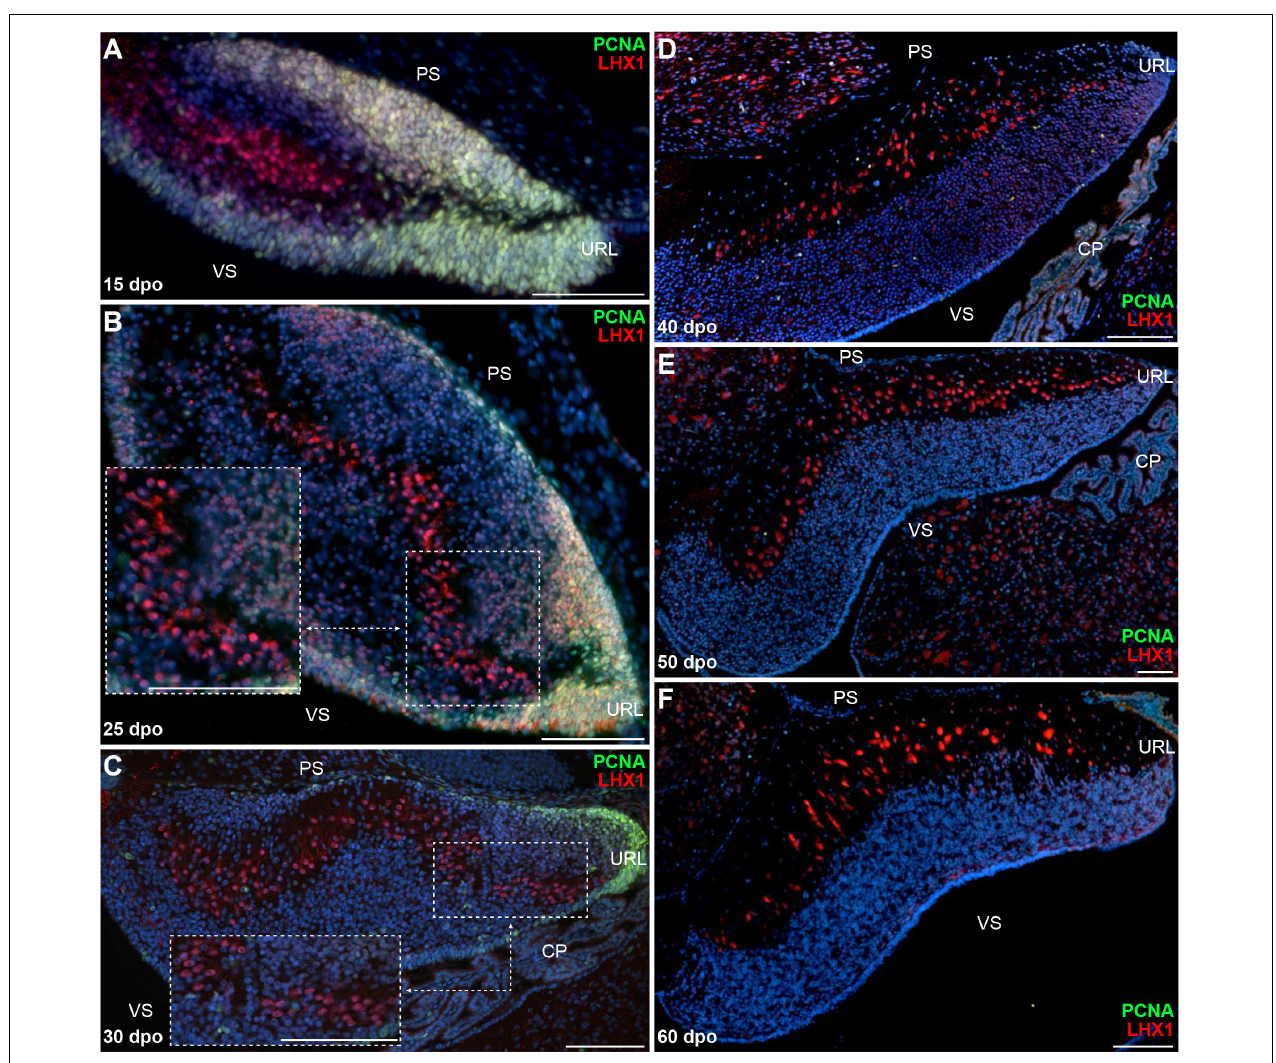
FIGURE 4 | Proliferation pattern and PC development in embryonic B. fuliginosus cerebellum. (A–F) Double IHC for PCNA (green staining) and LHX1 (red) markers at various developmental embryonic stages between 15 and 60 dpo in the cerebellum of B. fuliginosus . Insets in panels (B,C) show high magnifications of PC spatial organization. PS, pial surface; VS, ventricular surface; URL, upper rhombic lip; CP, choroid plexus. Scale bars: 100 µ